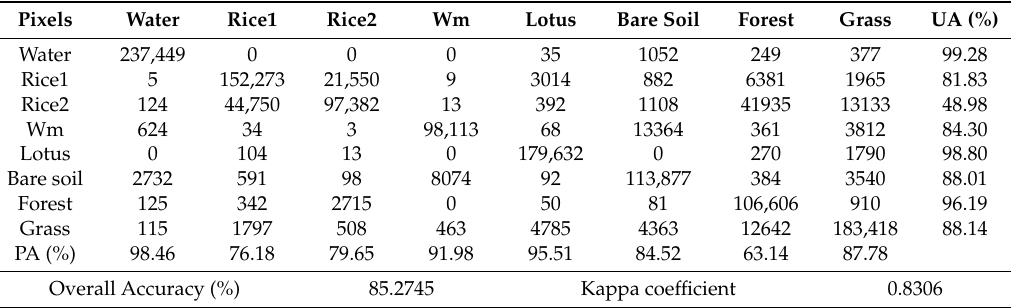
Table 4. Classification accuracy assessment of the integrated